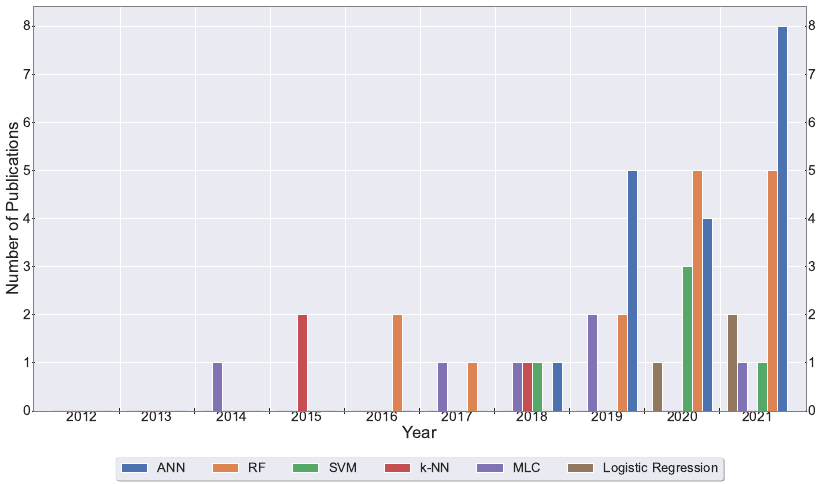
Figure 8. Distribution of different machine learning techniques used per year for image analysis over the selected publication